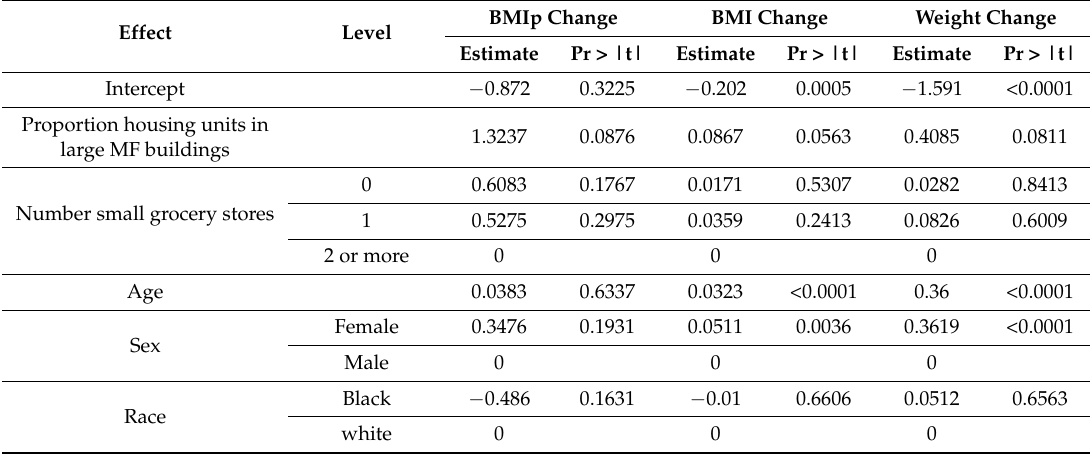
Table 7. Stratified Mixed Model, participants with normal weight in Spring 2010: Determinants of change in weight status (Outcome: Fall 2010 − Spring